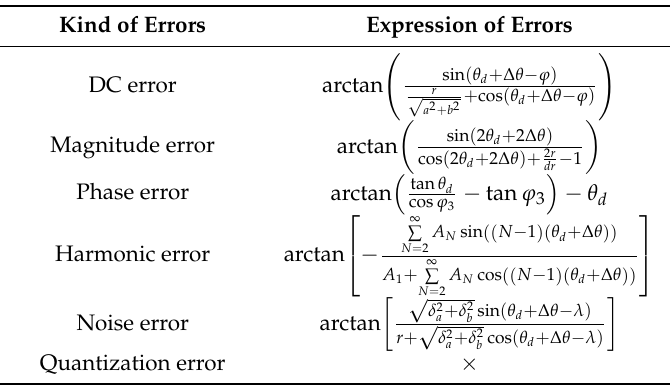
Table 1. Definition of the subdivision